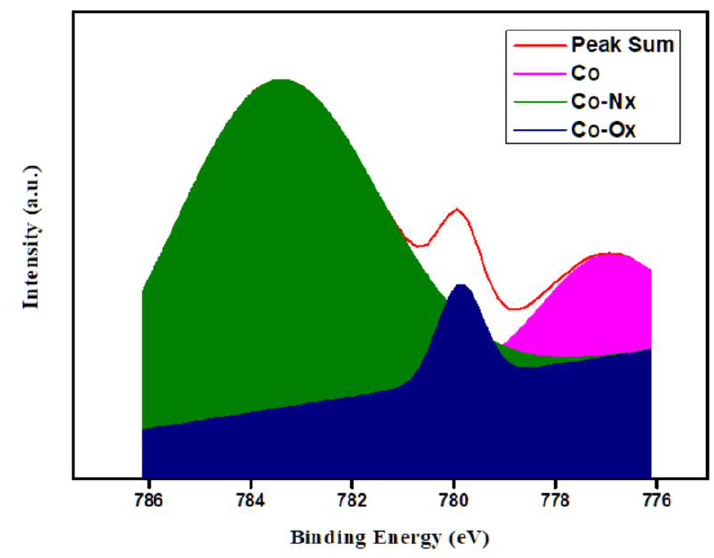
Figure 5. XPS-Co2p of CoNC-900A800.